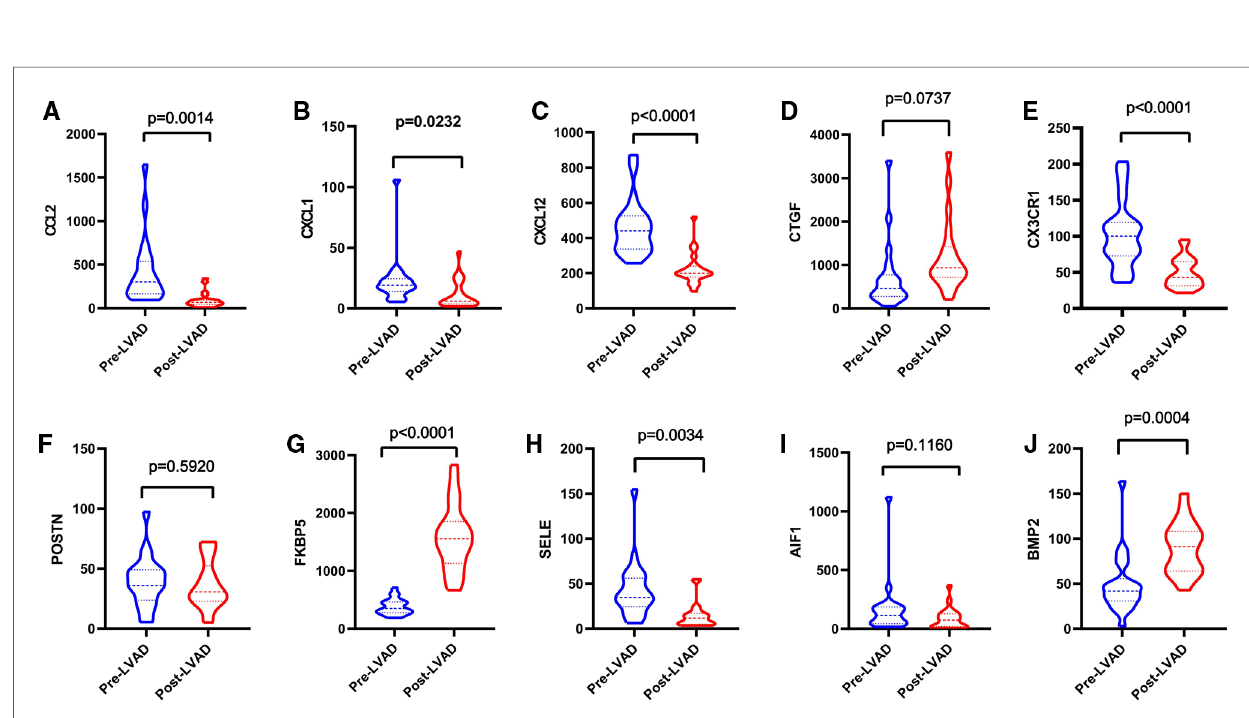
FIGURE 9 ( A – J ) Expressions of top 10 hub genes between pre-LVAD and post-LVAD groups in GSE21610. The blue ones were pre-LVAD groups. The red ones were post-LVAD